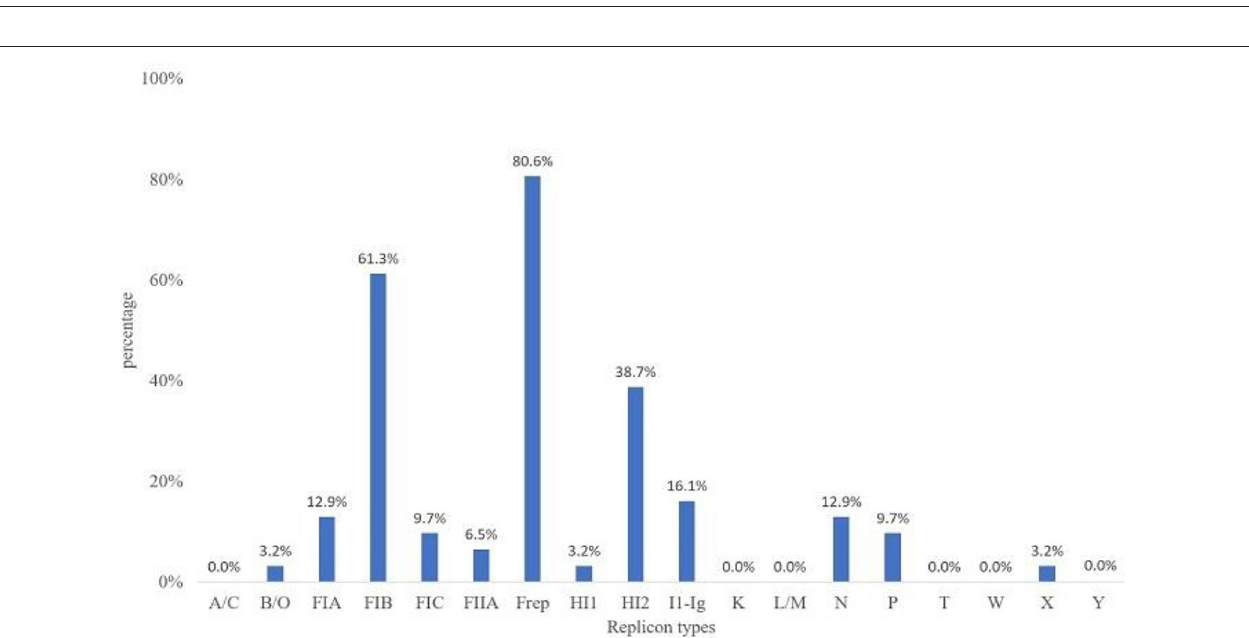
FIGURE 4 | Plasmid replicon types detected among 31 MCRPE isolates in contracted pig farms in Thailand.